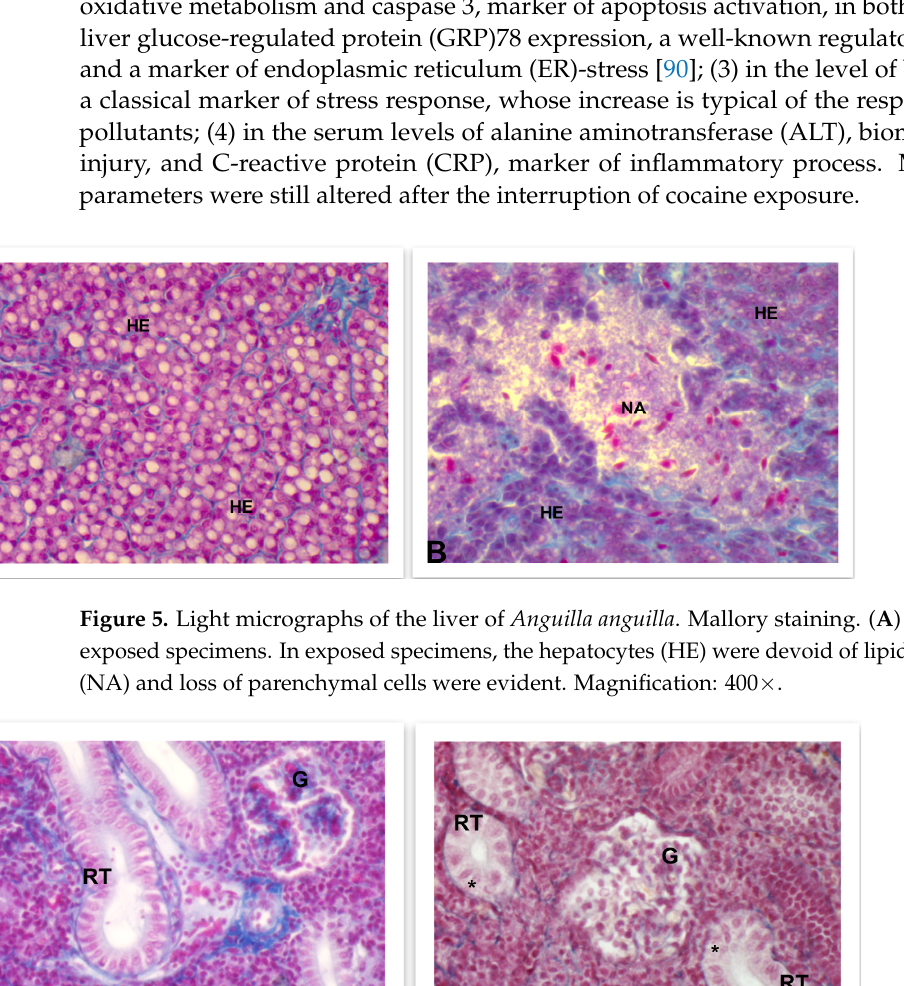
Figure 4. Light micrographs of the skeletal muscle of Anguilla anguilla . Mallory staining. ( A ) Control and ( B ) exposed specimens. In exposed specimens, the muscle fibres (M) showed less compactness and numerous breaks. Magnification: 400×.